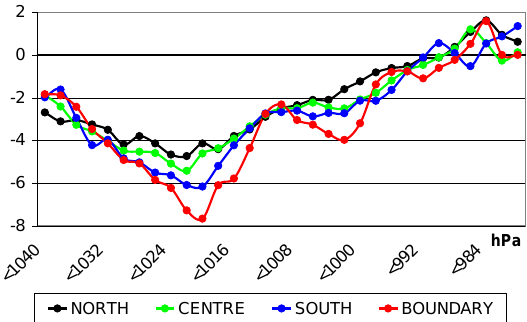
Figure 4. t-test statistics (y-axis) for the cumulated distribution of number of hours below fixed thresholds with 2 hPa-step from 980 to 1040 (x-axis) at the four points shown in figure1, left panel. Positive values of the t-test statistics indicate that values are higher in the future than in the present period.